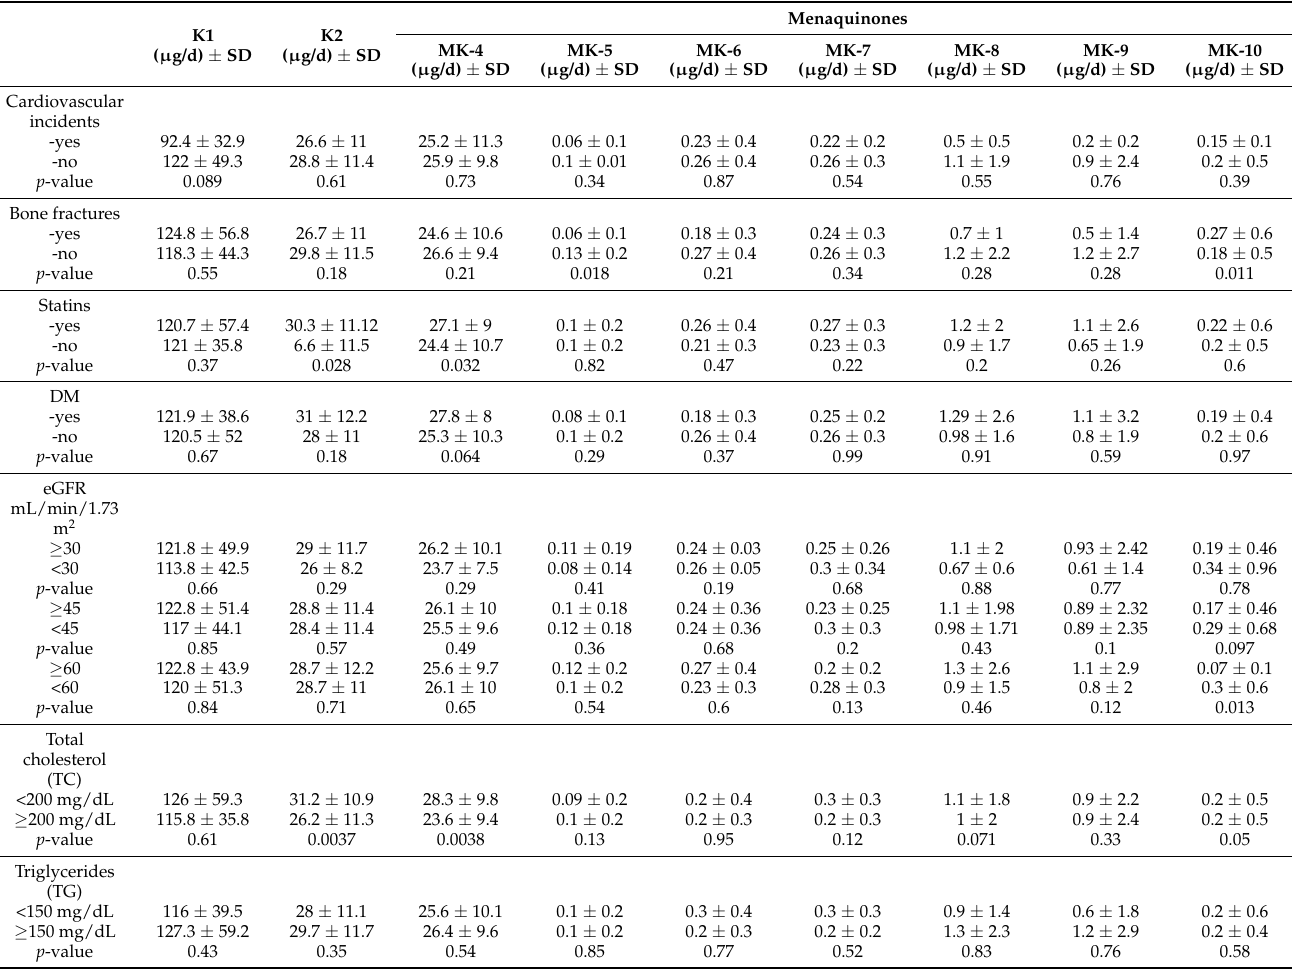
Table 2. The daily intake of vitamins K1, K2 and its isoforms MK-4 to MK-10 in relation to comorbidi- ties, medications taken and selected laboratory